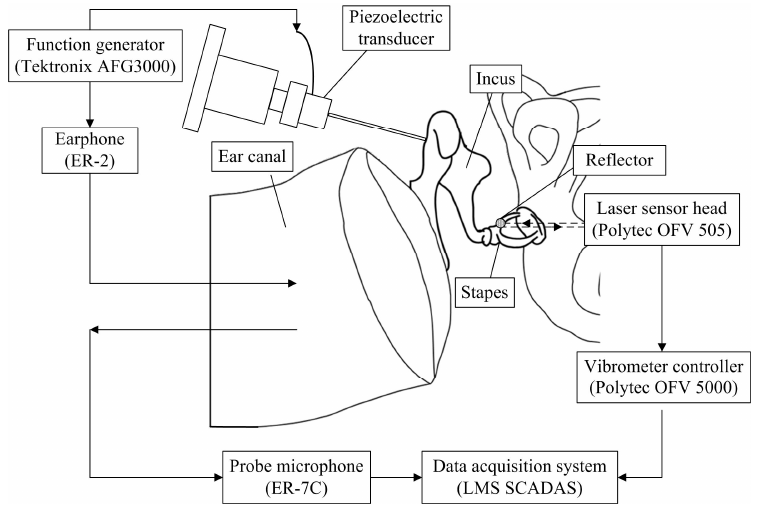
Figure 2. Experiment setup of the measurement system of the temporal bone experiment.